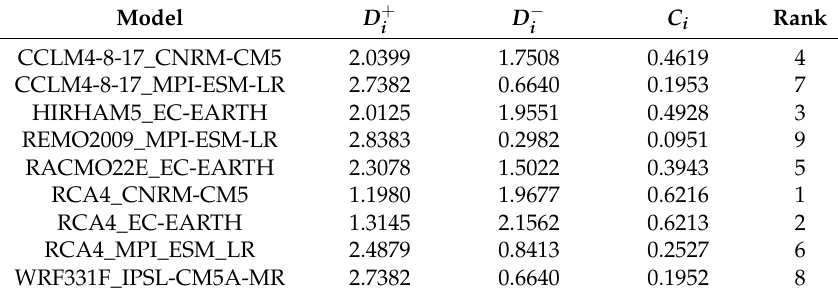
Table 6. Ranking pattern of global climate models.